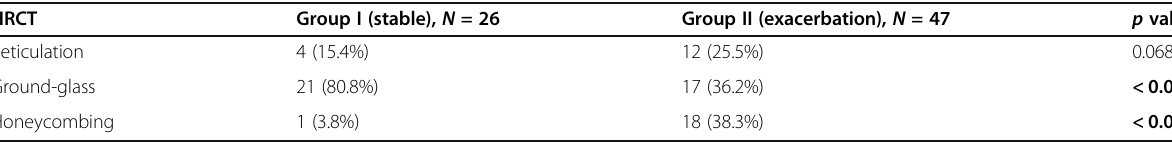
Table 3 Radiological findings of the diseased groups HRCT Group I (stable), N = 26